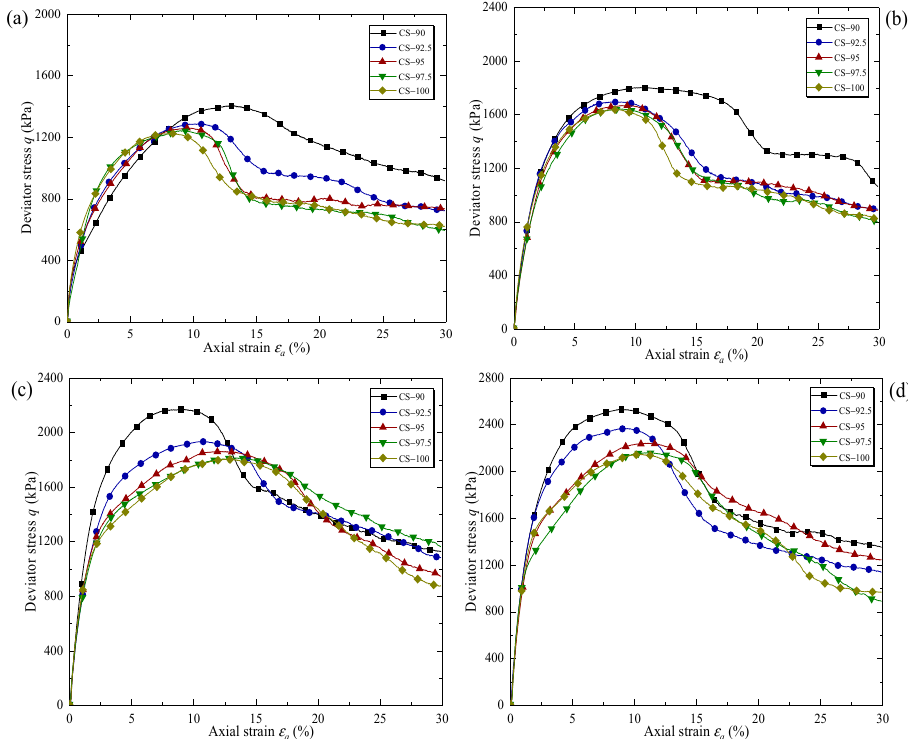
Figure 4. Deviator stress-axial strain curves of coral sand with different saturations: ( a ) σ 3’ = 200 kPa; ( b ) σ 3’ = 400 kPa; ( c ) σ 3’ = 600 kPa; ( d ) σ 3’ = 800 kPa.